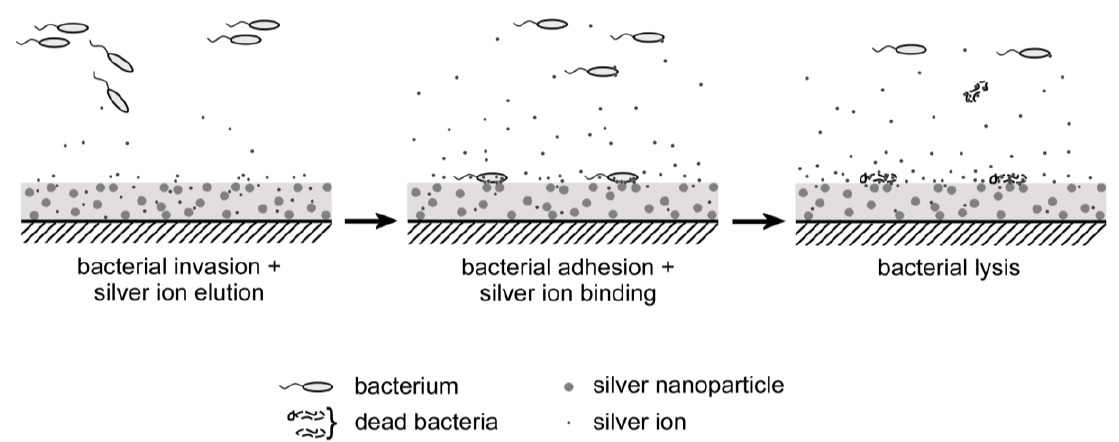
Figure 4. Antibacterial mechanism of silver. A surface coating containing silver nanoparticles will slowly release silver ions into the coating layer and subsequently the solution. Silver ions will bind the bacterial membrane and proteins, causing cell lysis. The silver ions can originate from the solution, but may also be transferred directly from the surface exposed silver to the bacteria without being dissolved in the